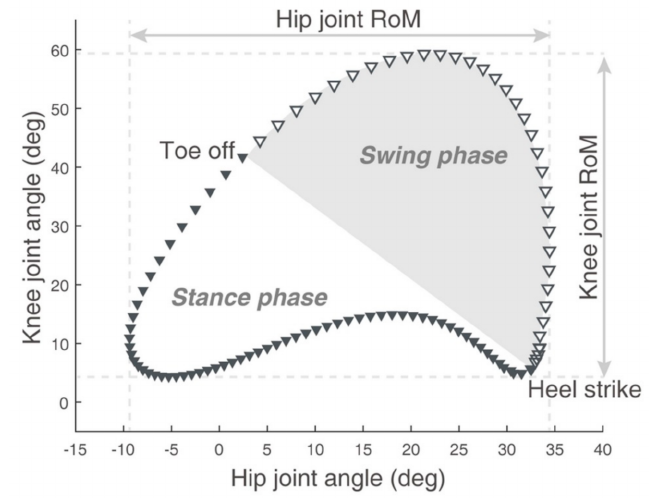
Figure 2. A representative sagittal plane hip–knee cyclogram. Hip and knee joint angles (degrees) during the gait cycle are plotted in the clockwise direction on the X– and Y–axes, respectively. The gait cycle is divided into stance (filled inverted triangles) and swing (open inverted triangle) phases. RoM = range of motion. This “Figure 2” by Park et al., is licensed under CC BY 4.0, modified from the original